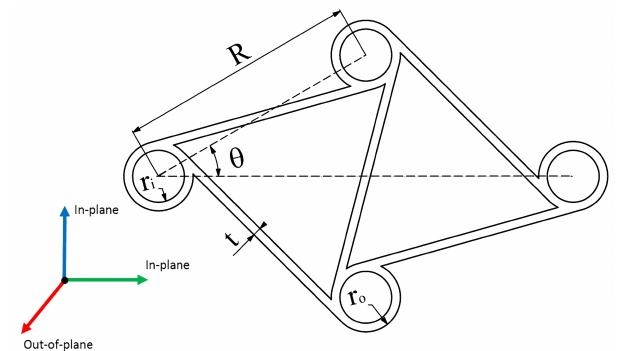
Figure 2. The production stage of the hexachiral lattice.